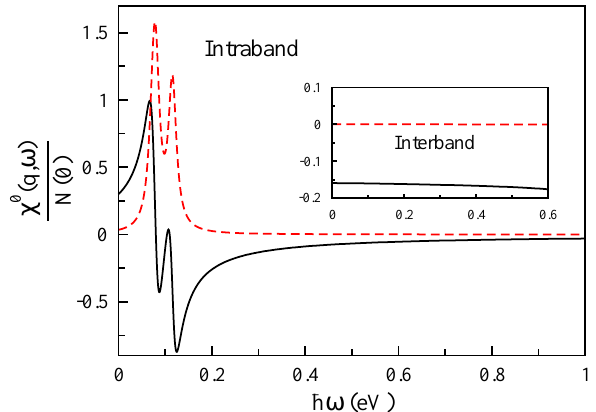
Figure 20. The non-interacting response function in units of the Fermi-level density of states as a function of ¯ h ω of bilayer phosphorene for q = 0.046 Å − 1 .